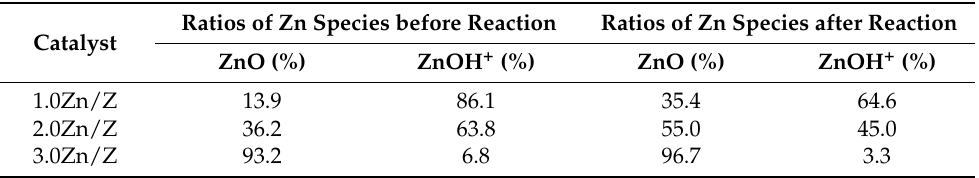
Table 2. Ratios of Zn species measured by fitting of XPS Zn 2 p 3/2 peaks on 1.0Zn/Z, 2.0Zn/Z